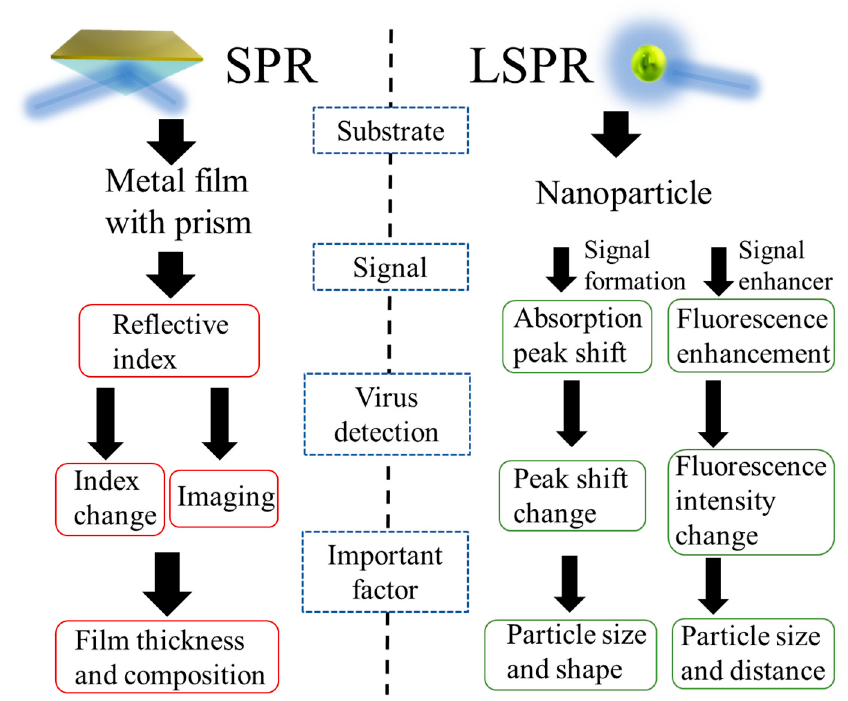
Figure 1. Diagram summarizing the foundation, signals to be used, signal measurement methods, and critical factors as building elements for a virus detection system using SPR and LSPR.